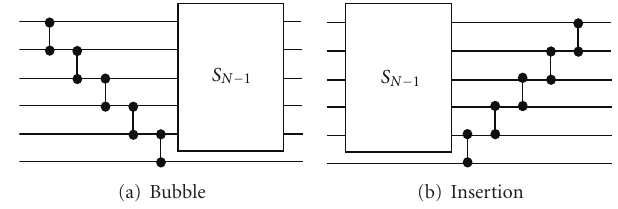
Figure 1: Sorting networks of size N .